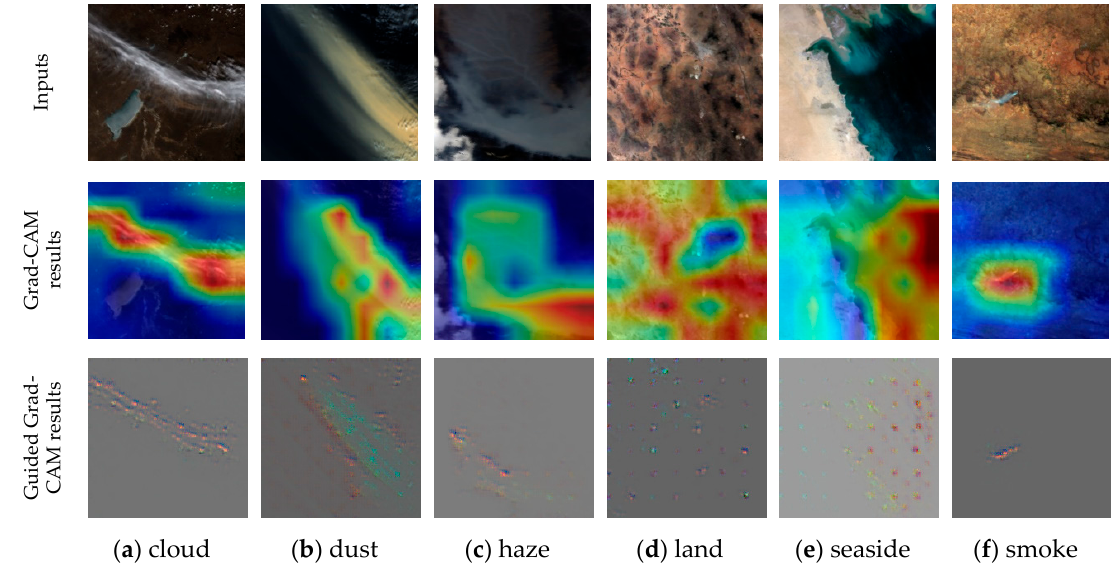
Figure 6. Visualizations for the example images from six classes. The first row shows the input images, and the second and third rows present the visualizations of Grad-CAM and Guided Crad-CAM approaches, respectively.